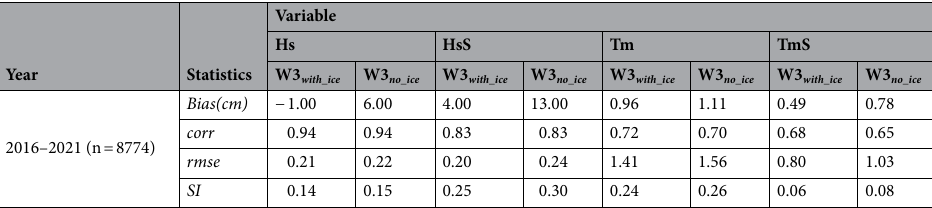
Table 1. Validation statistics of significant wave height (Hs), swell wave height (HsS), wave period (Tm) and swell wave period (TmS), averaged over the six NIO mooring locations for the SON period of 2016–2021. The statistics are valid at 95% confidence level ( p = 0.05).